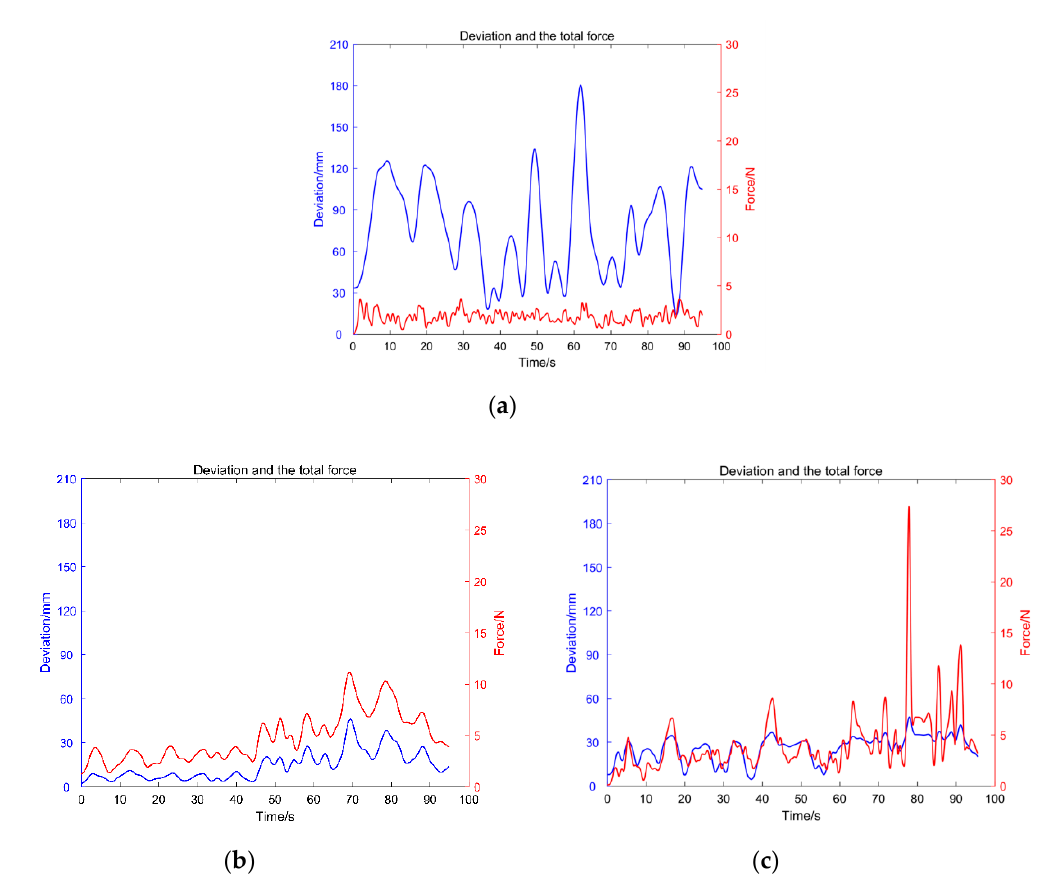
Figure 12. The position deviation between the subject’s hand and the desired trajectory, and the total interaction force between the participant’s hand and the robot’s handle during the three testing tasks. ( a ) the position deviation and the total interaction force for the task 1; ( b ) the position deviation and the total interaction force for the task 2; ( c ) the position deviation and the total interaction force for the task 3.